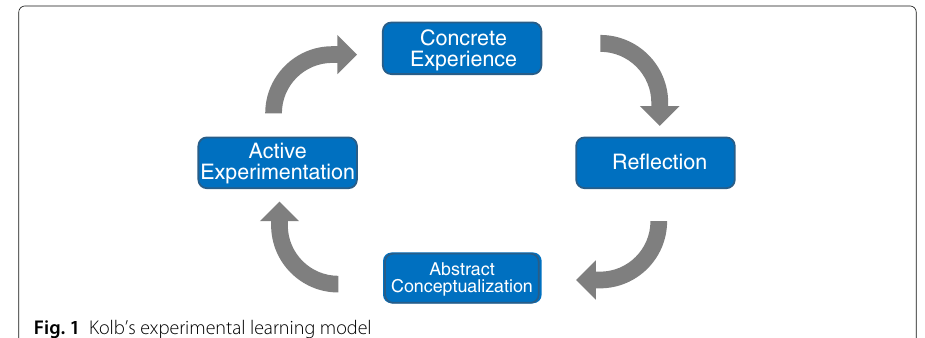
Fig. 1 Kolb’s experimental learning model